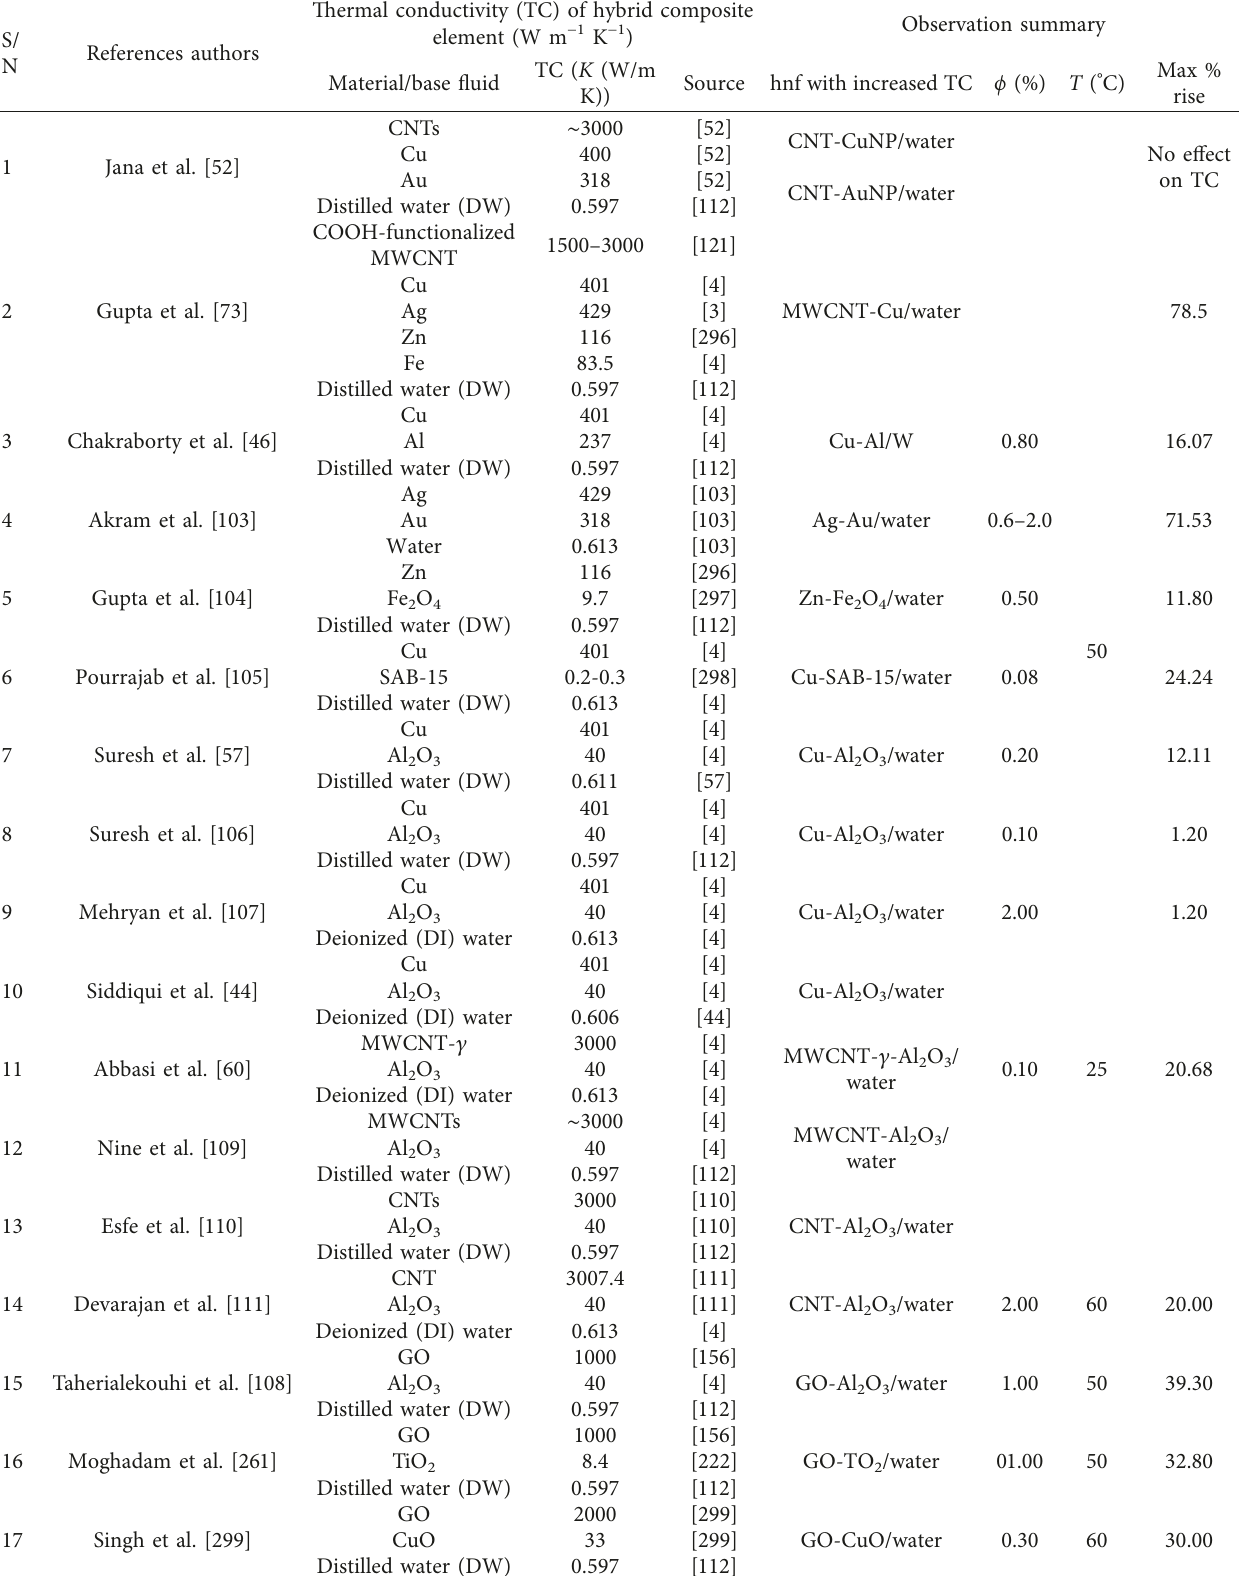
Table 5: Summary of results from published literature on thermal conductivity of various hybrid